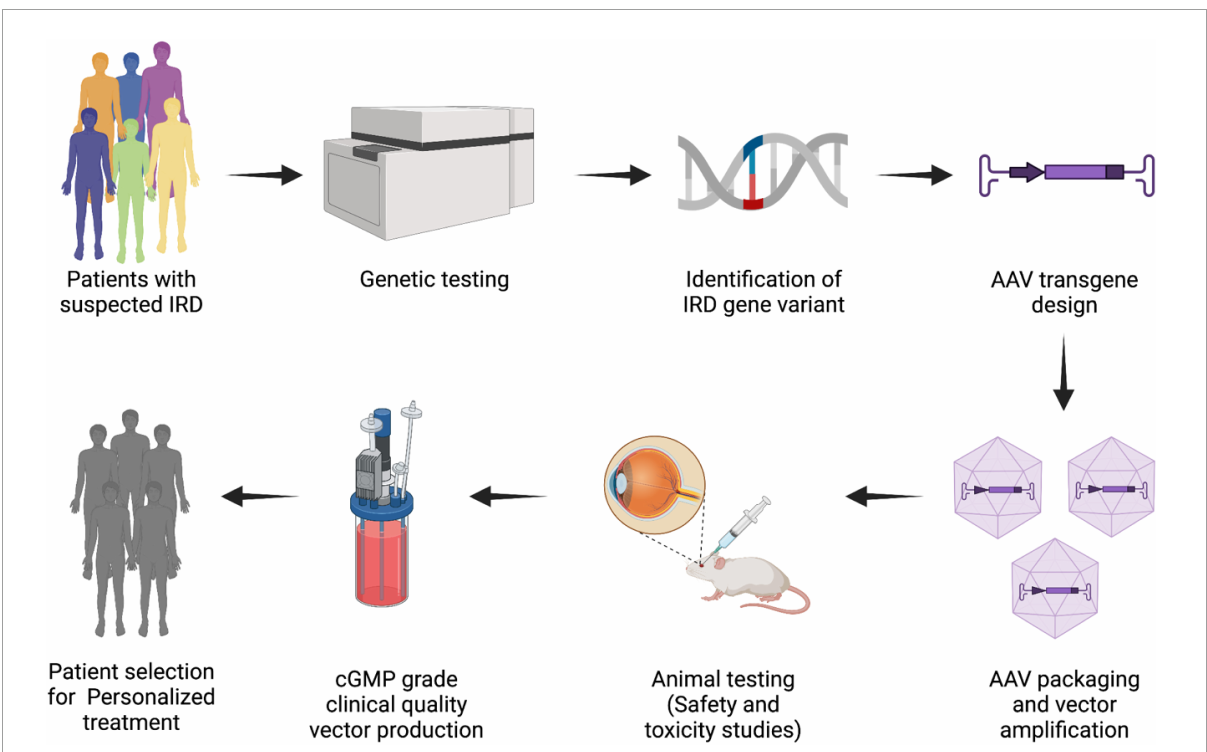
FIGURE3 Overview of bench to bedside approach for personalized treatment. Advances in genomic analysis allow for genetic evaluation and diagnosis of IRDs. Further evaluation of the genetic etiology helps in translating it to gene therapy based personalized therapeutic options. This schematic focuses on AAV as the vectors of choice for gene therapy in the retina, due to the limitation of lentiviruses and adenoviruses in transducing the mature